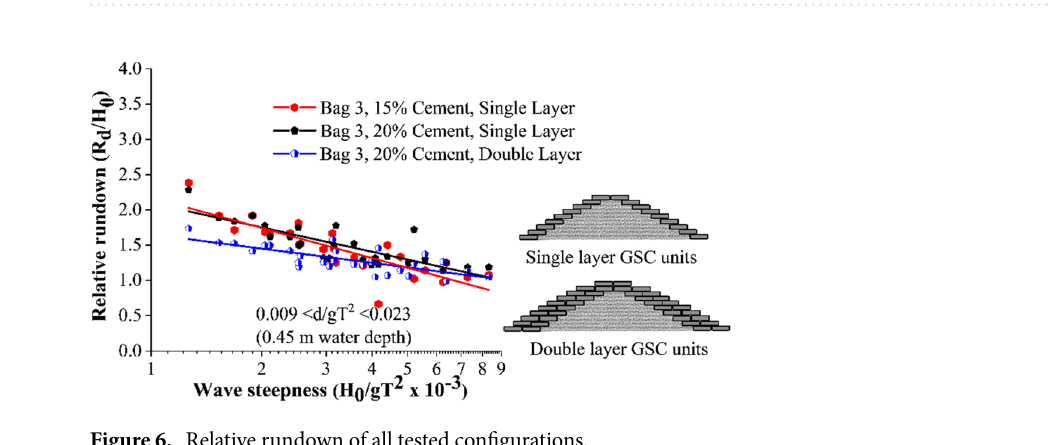
Figure 5. Relative runup vs wave height to depth ratio (H 0 /d) of all the tested configurations.